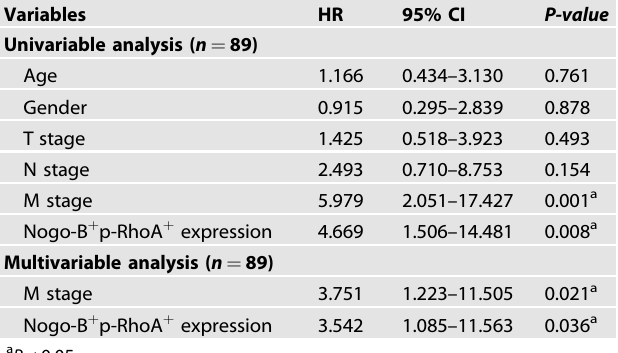
Table 4. Univariable and multivariable